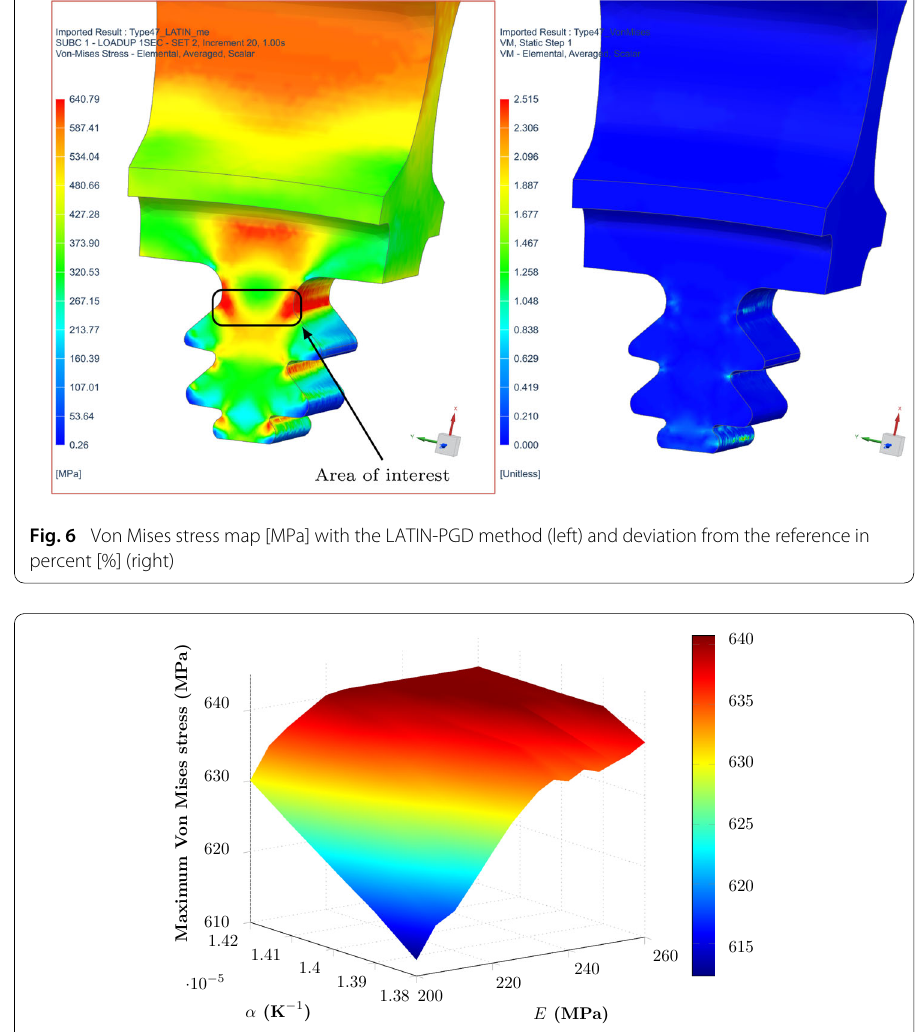
Fig. 7 Maximum Von Mises stress in the contact area according to both E and α parameters resulting